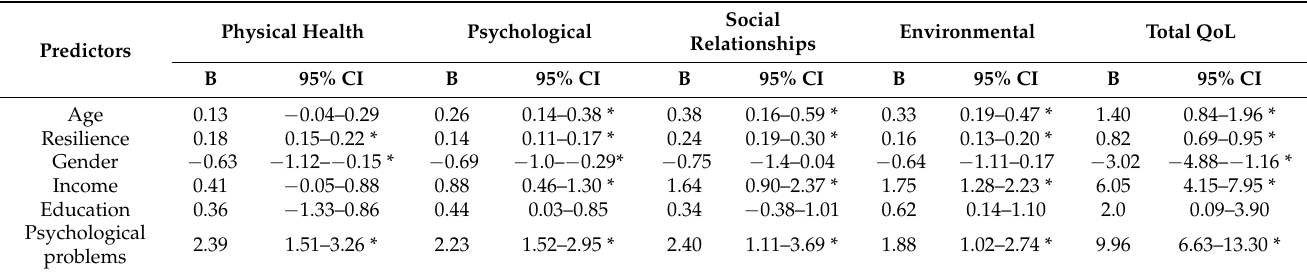
Table 6. Simple linear regression analysis of the QoL and the four domains as dependent variables (N = 385).